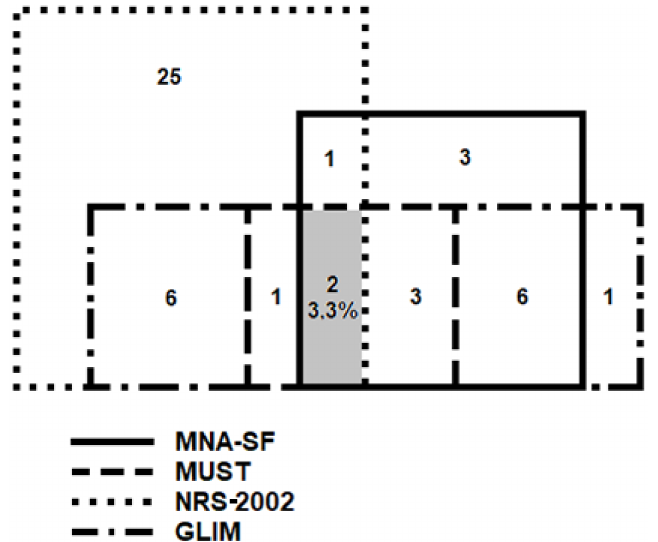
Figure 3. Number of patients with malnutrition diagnosed based on results of the MNA-SF, MUST, NRS-2002 questionnaires and the GLIM criteria. Notes: MNA-SF, Mini Nutritional Assessment— Short Form; MUST, Malnutrition Universal Screening Tool; NRS-2002, Nutritional Risk Score; GLIM, Global Leadership Initiative on Malnutrition. The grey area denotes overlapping of the MNA-SF, MUST, NRS-2002, and GLIM results for malnutrition.